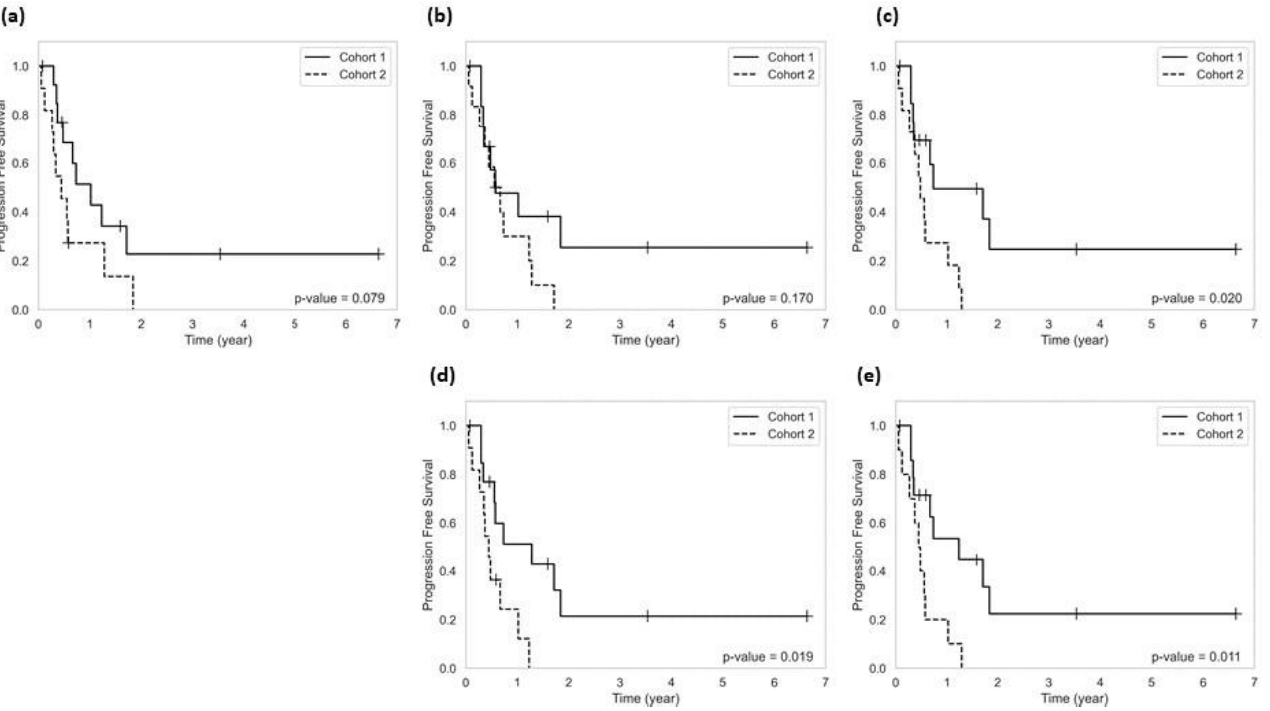
Figure 4. Kaplan – Meier progression-free survival curves for two cohorts of patients stratified based on the outcome prediction by the radiomic models developed with different segmentation